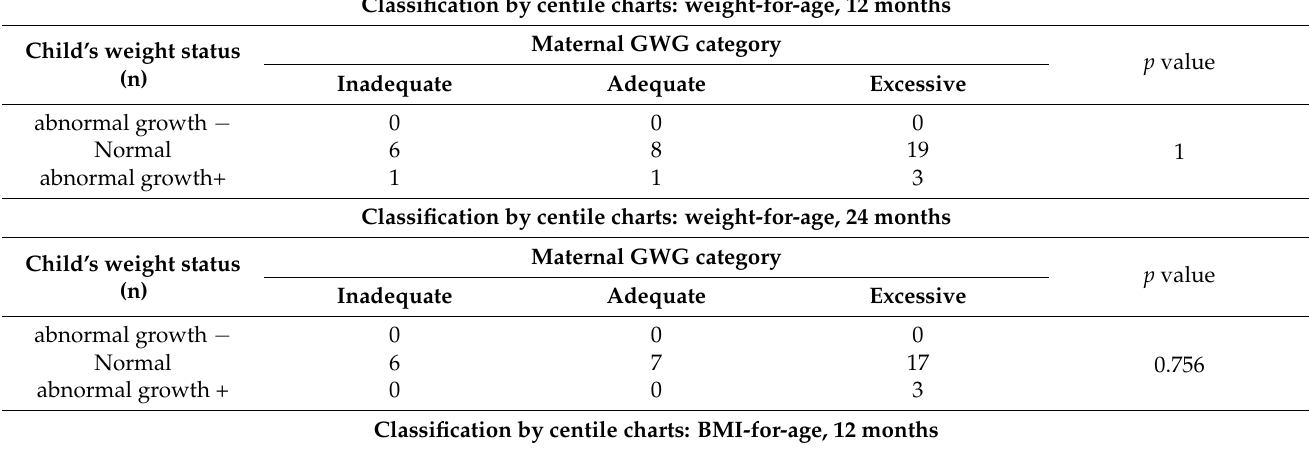
Table 5. Cont. Classification by centile charts: weight-for-age, 12 months